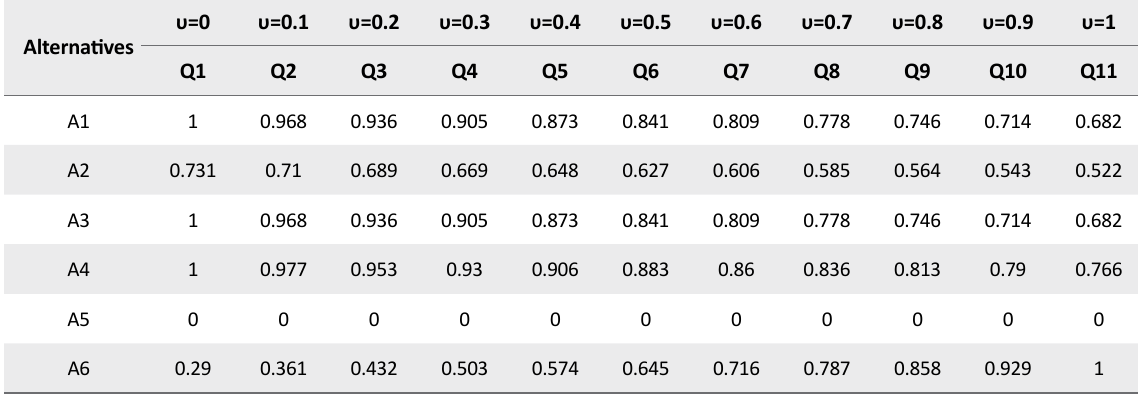
Table 6. Results of sensitivity analysis by using Fuzzy VIKOR method